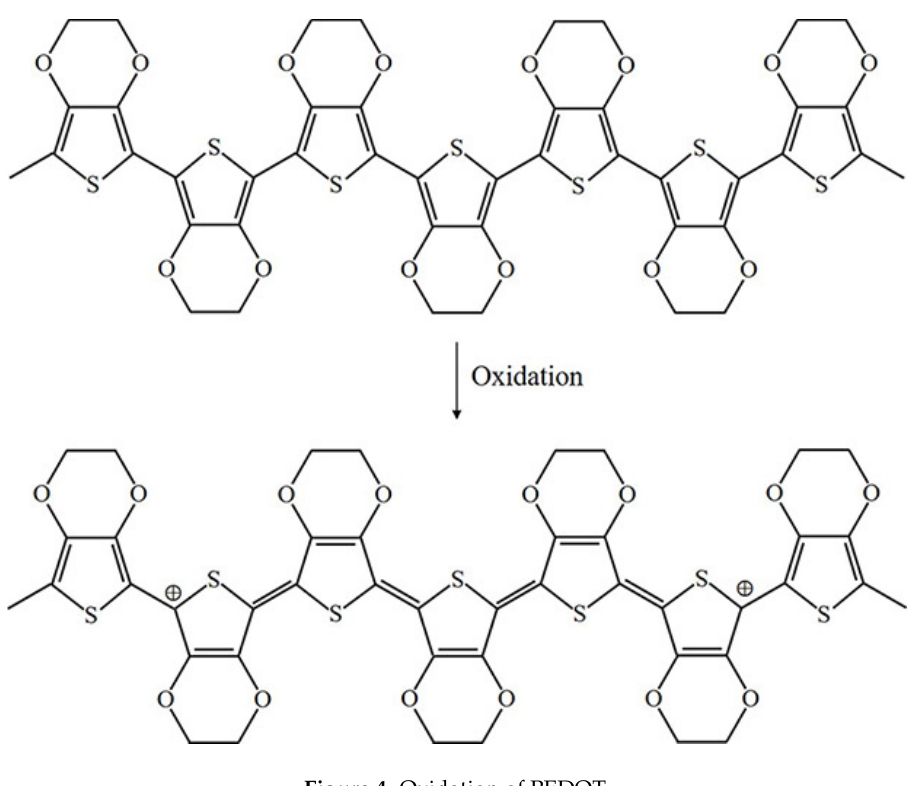
Figure 4. Oxidation of PEDOT.